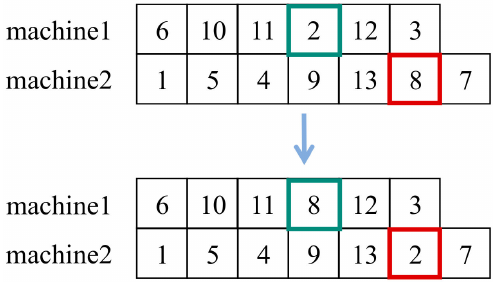
Figure 3. Schematic diagram of mutation.